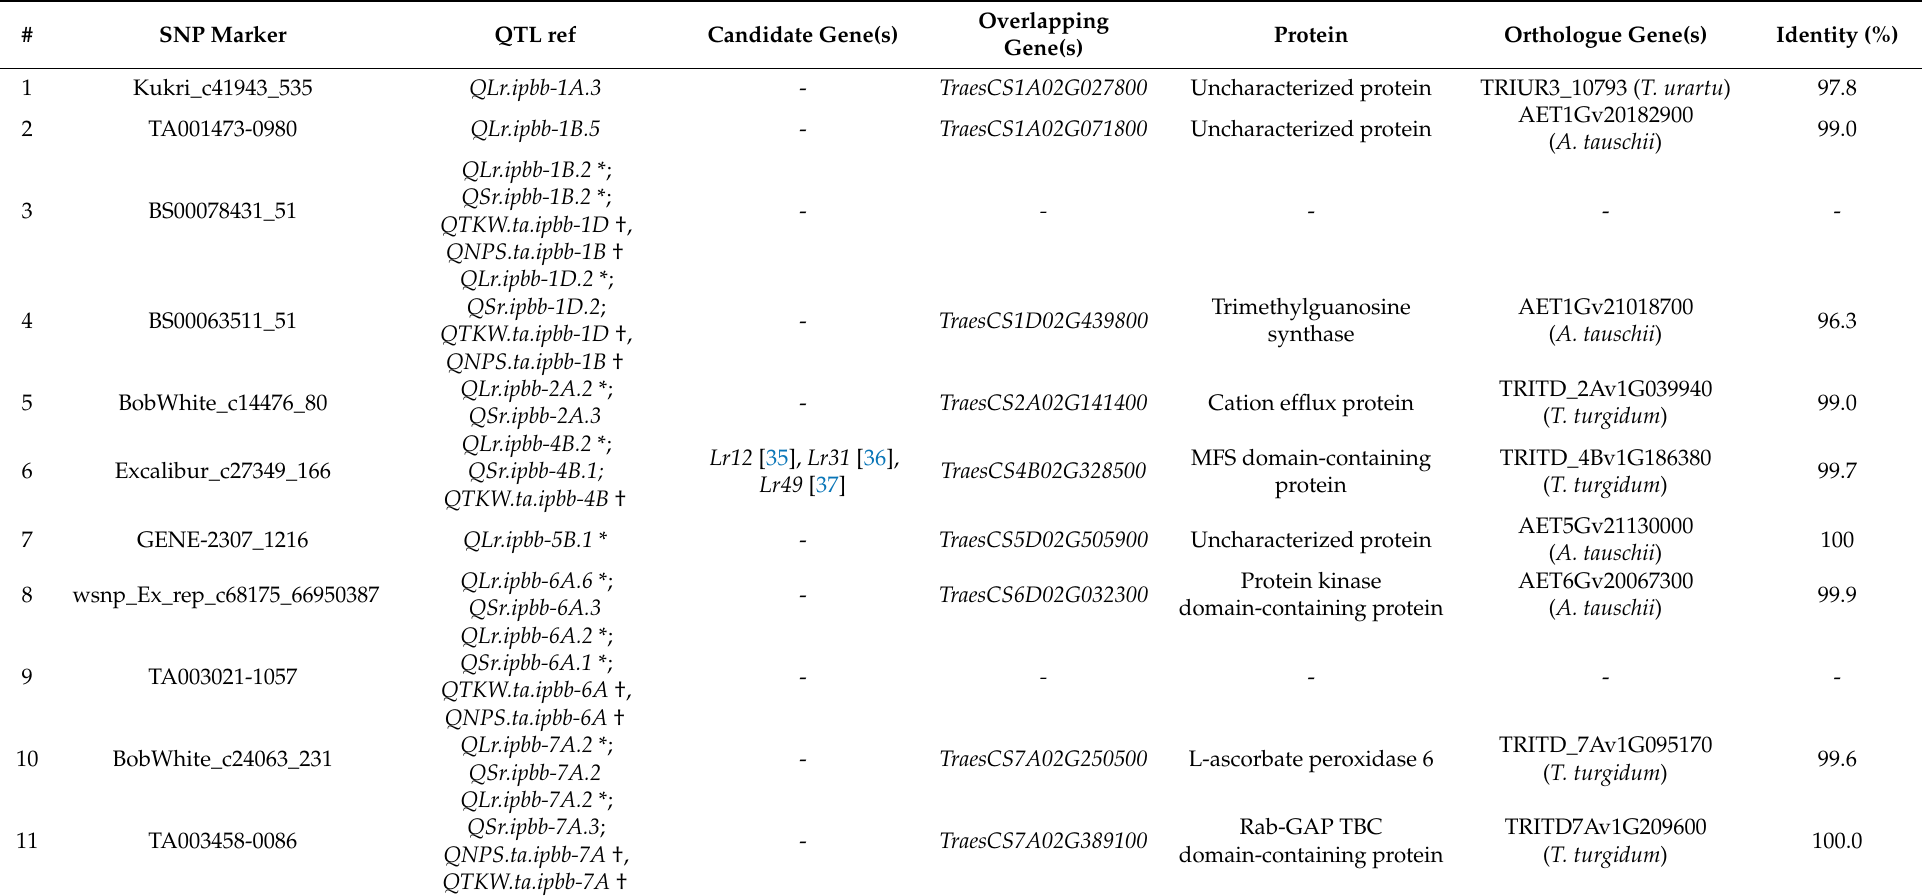
Table 4. Comparison of quantitative trait loci (QTLs) of seedling resistance to leaf rust (LR) and stem rust (SR) identified in this study with previously described QTLs and candidate Lr and Sr